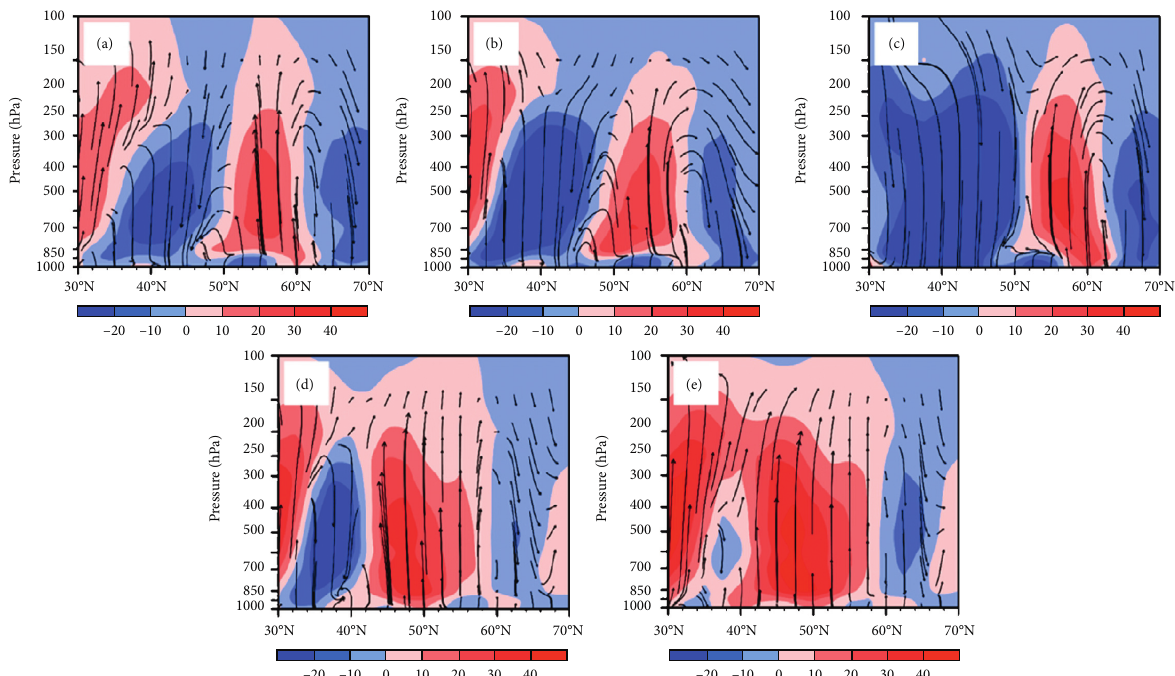
Figure 10: Meridional-vertical cross-sections for anomaly fields of vertical velocity (vector) and meridional wind (shadow, unit: m · s − 1 ) along 125 ° E (with ʋ and ω × 100) for NCVs in (a) May-September, (b) late spring, and (c) early autumn and MCVs in (d) May-September and (e) summer.